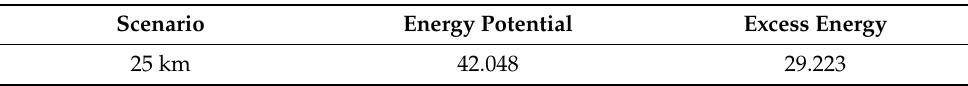
Table 4. UAE’s results for PV energy potential and excess energy in GWh.